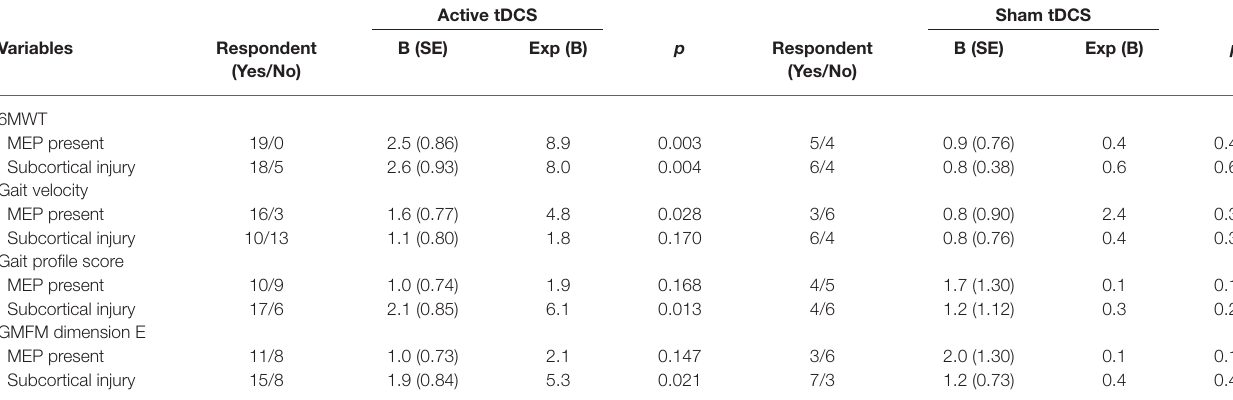
TABLE 2 | Results of linear logistic regressions in the active and sham tDCS groups. Active tDCS Sham tDCS